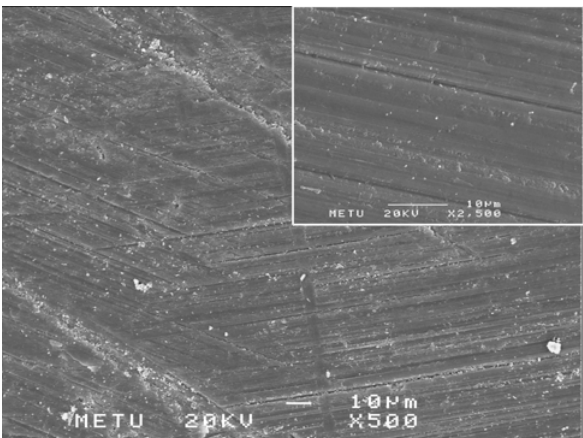
FIGURE 3- SEM analysis showing the enamel surface after residual resin removal with Sof-Lex aluminum oxide abrasive